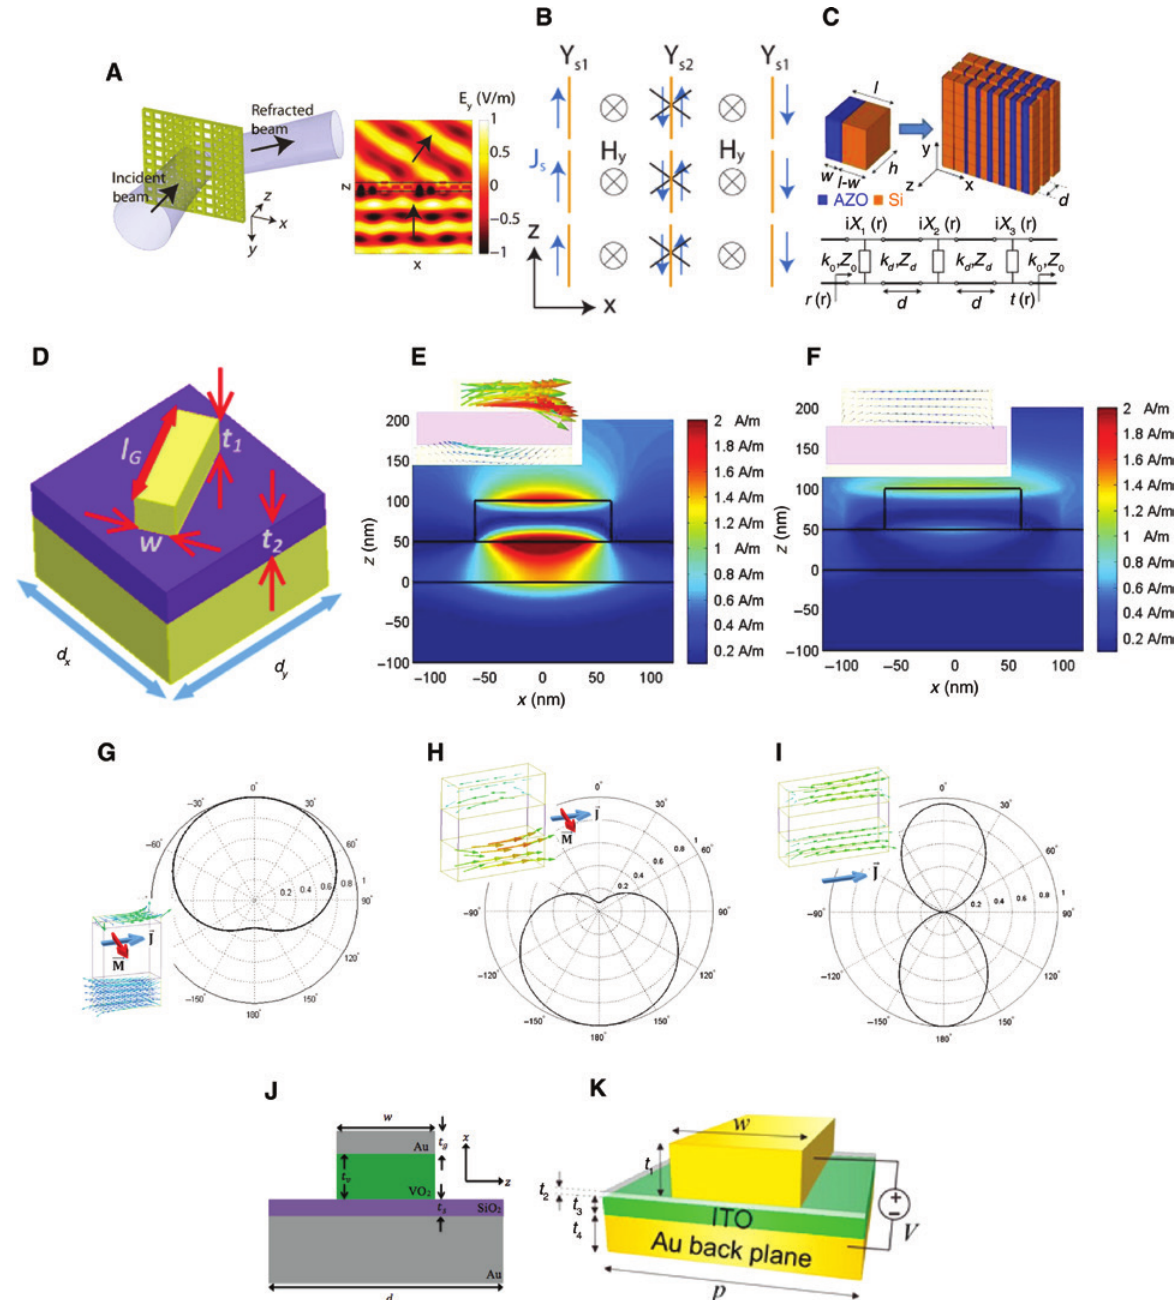
Figure 20: Metallic optical Huygens’